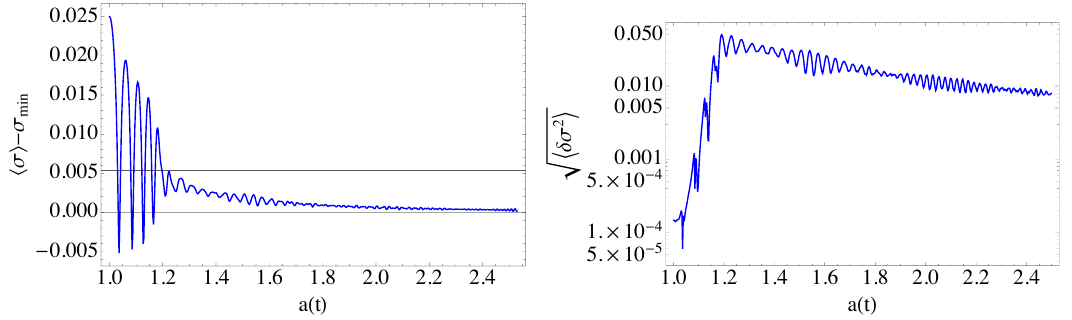
Figure 10 . The potential of the blow-up K(cid:127)ahler modulus in terms of the canonically normalised (cid:12)eld, normalised to the height of the plateau V 0 ’ 1 : 794 (cid:2) 10 (cid:0) 12 M 4 to zero. The black line denotes the in(cid:13)ection point. The parameter choices are: W 0 = A i = (cid:24) = a 2 = 1, g s = 0 : 2, (cid:13) = 2 and n = 10 :